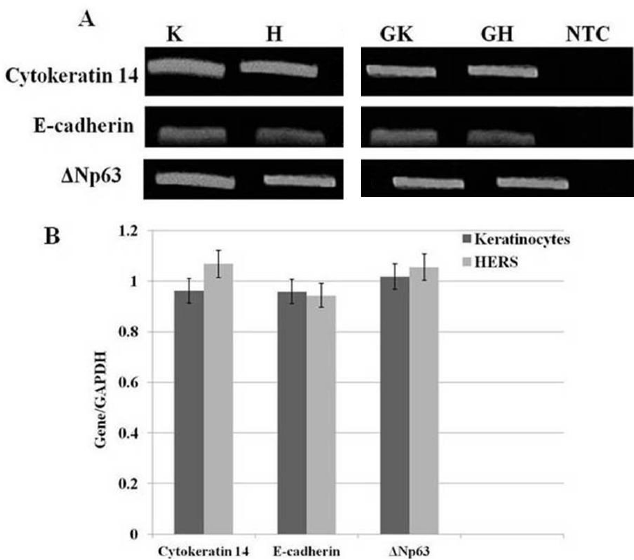
Figure 5. Gene expression of cytokeratin 14 , E-cadherin , and Δ Np63 in HERS cells (H) and keratinocytes (K) ( A ). Both cell types were positive for the presence of cytokeratin , E-cadherin , and Δ Np63 . GAPDH in keratinocytes (GK), GAPDH in HERS (GH). No-template control (NTC) consisting of distilled water in place of template. Semi-quantitative RT-PCR analysis of the cytokeratin 14 , E-cadherin , and Δ Np63 genes in HERS cells and keratinocytes ( B ). The expression level of each gene was normalized to the corresponding GAPDH endogenous control. The data showed no significant differences between the groups.